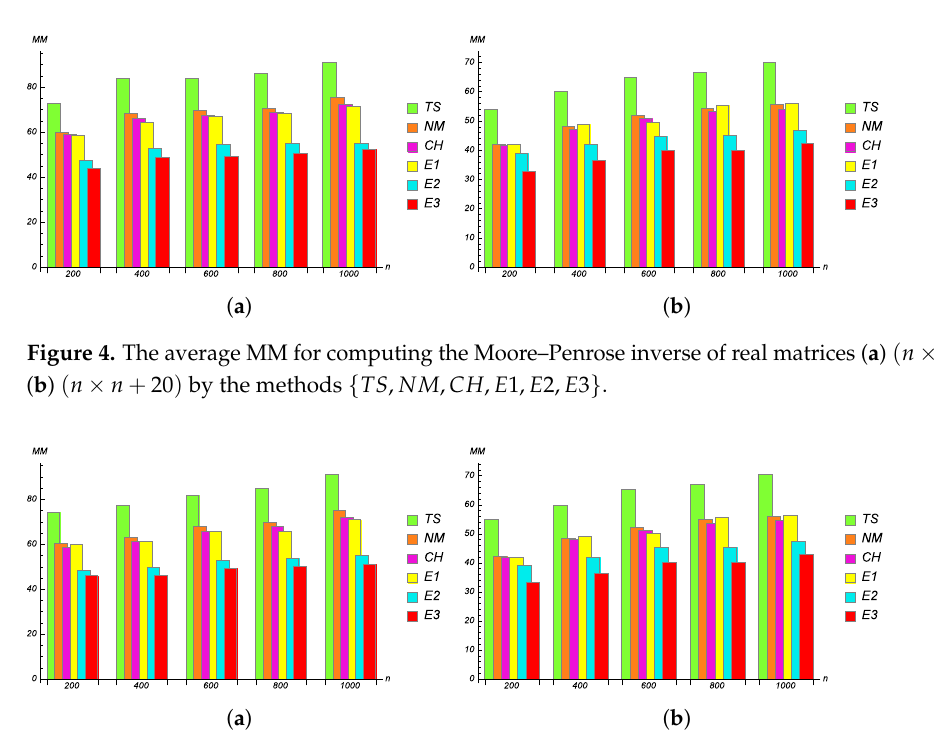
Figure 5. The average MM for computing the Moore–Penrose inverse of complex matrices ( a ) ( n × n ) and ( b ) ( n × n + 20 ) by the methods.